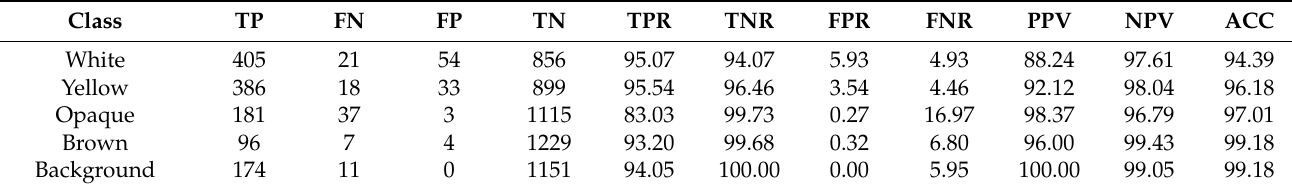
Table 3. Performance of pixel-wise classification based on multiple prototypes.